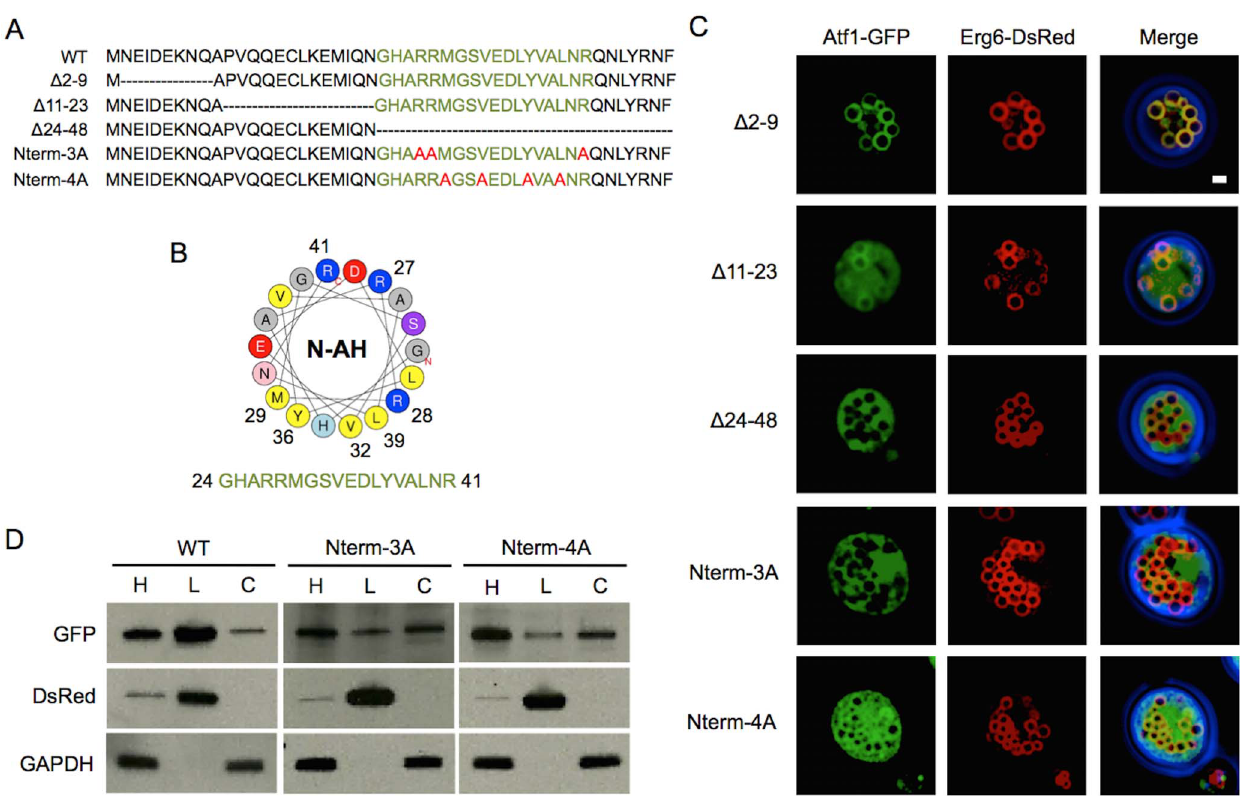
Figure 2. The N-terminal amphipathic helix of Atf1 is necessary for LD localization. (A) N-terminal sequences studied. The amino acid sequences of the predicted amphipathic helix are shown in green with point mutations to alanine shown in red. (B) Helical wheel projection of the N- terminal helix. Hydrophobic residues are colored yellow, neutral in gray, basic in blue, and acidic in red. The numbered basic residues were mutated to alanine in Nterm-3A and the numbered hydrophobic residues were mutated to alanine in Nterm-4A. (C) Fluorescent images of stationary phase cells cultured in oleic acid media overexpressing Atf1-GFP, truncates, and mutants with co-expression of the LD marker Erg6-DsRed. Truncation of residues 2–9 has no effect on LD localization while deletion of 11–23 and 24–48 attenuate LD localization. Mutation of residues in Nterm-4A and Nterm3A also attenuate LD localization. Scale bar, 1 m m. Quantification of fluorescence microscopy was performed by counting a minimum of 300 cells from three independent experiments. LD localization was observed in 89 6 4% of D 2–9 expressing cells and 25 6 8%, 0%, 0%, and 4 6 1% of